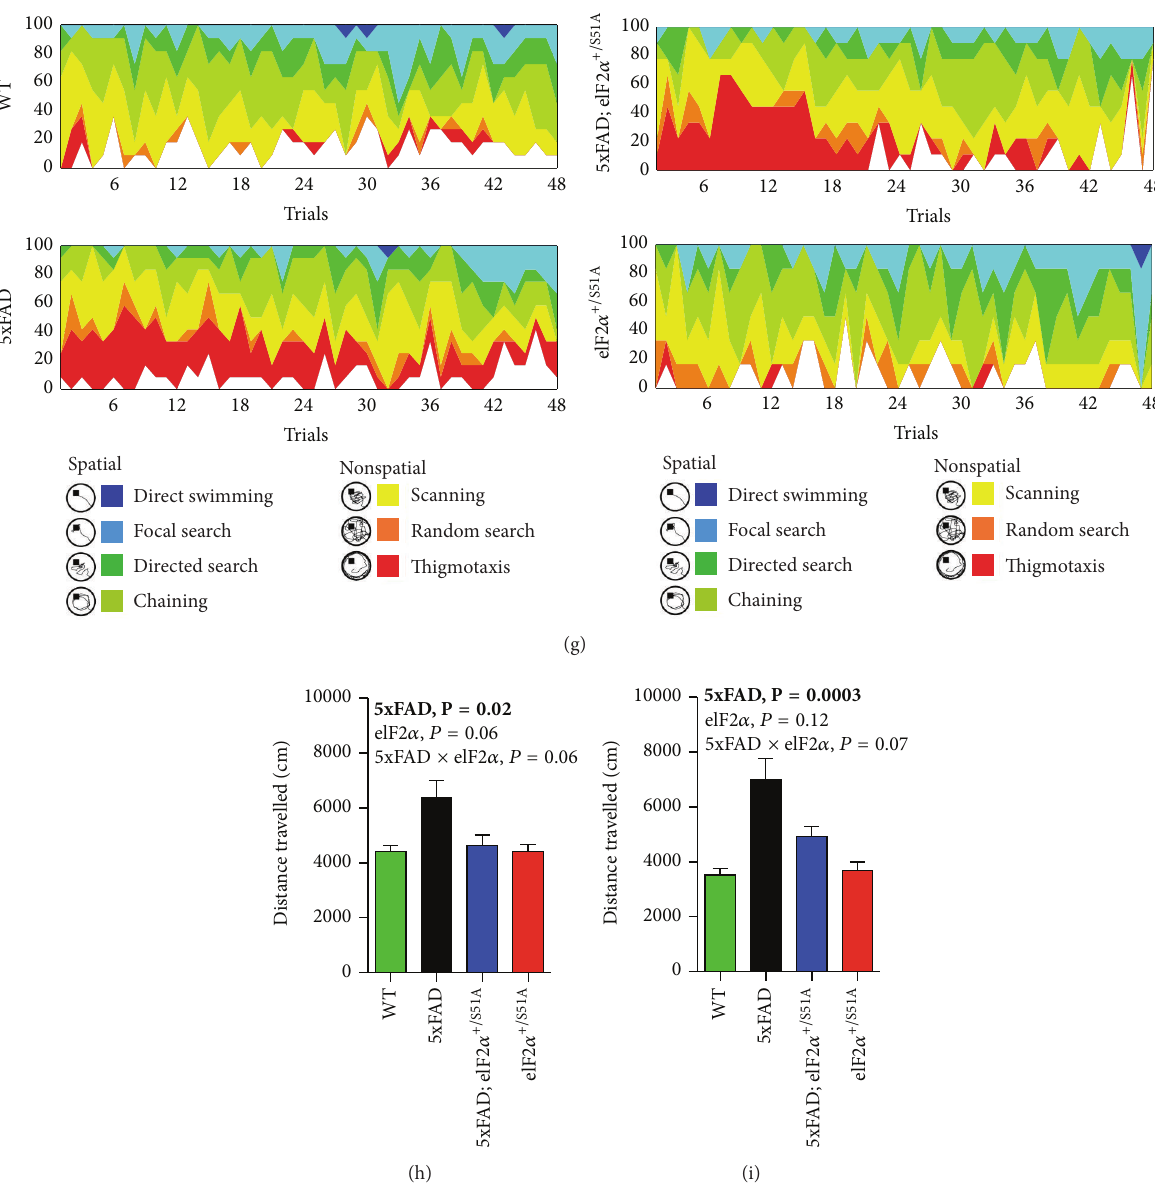
Figure 2: The 𝑒𝐼𝐹2𝛼 S 51 A allele had limited effects on most neurological phenotypes but restored hyperactivity in 5xFAD mice. (a)